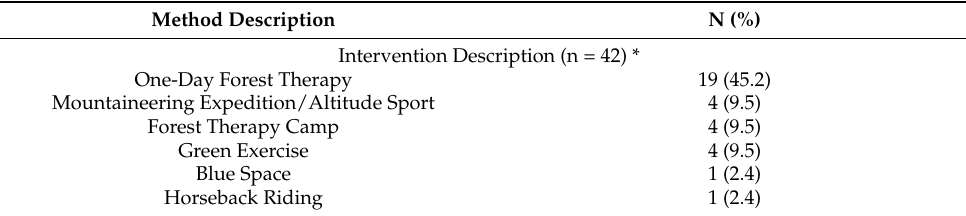
Table 3. Method Characteristics of HRV Studies in Outdoor